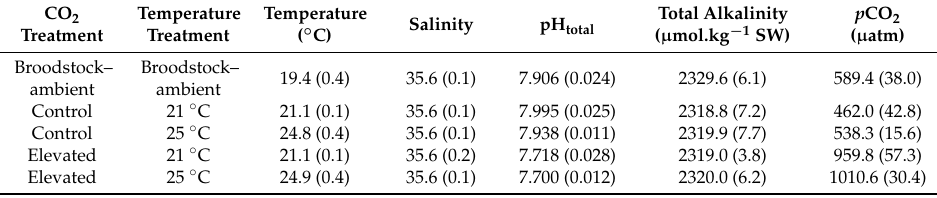
Table 1. Experimental water chemistry. Mean ( ± S.D.) temperature, salinity, pH total , total alkalinity, and p CO 2 in experiments with yellowtail kingfish ( Seriola lalandi ) eggs and larvae. Water chemistry in broodstock tanks was measured in the week prior to spawning. Temperature, salinity, pH total , and total alkalinity were measured directly, while p CO 2 was estimated from these parameters in